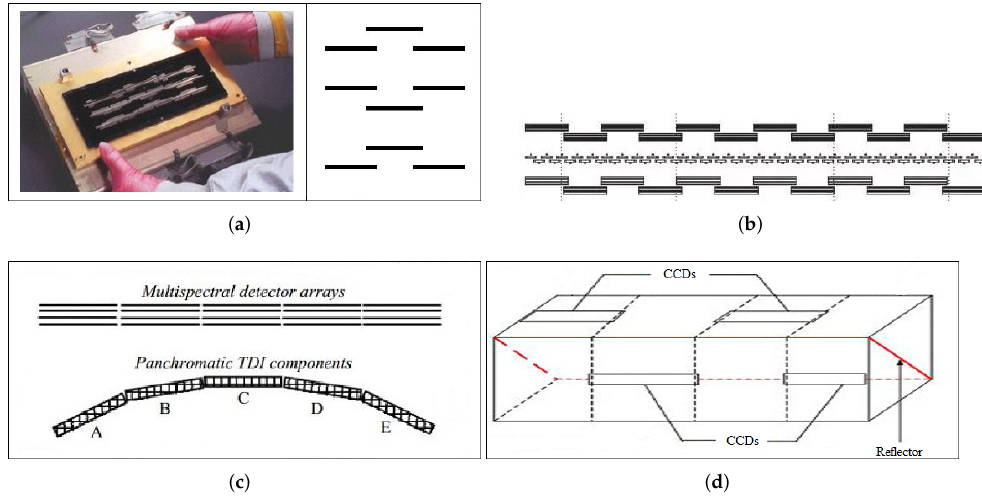
Figure 1. Focal plane arrangement of different satellite platforms: ( a ) IKONOS imaging plane, ( b ) WorldView-2 imaging plane, ( c ) Pleiades imaging plane(Letters A E is the index of inner CCD sensors), ( d ) ZY-3 imaging